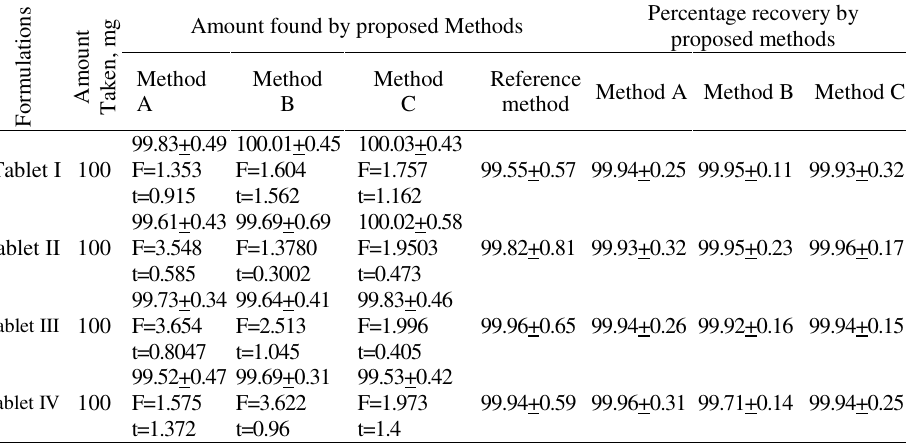
Table 3. Assay of FXA in pharmaceutical formulations Amount found by proposed Methods